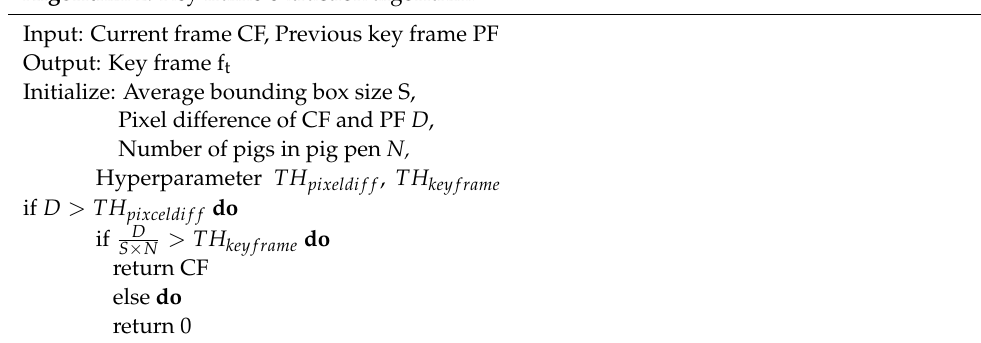
Algorithm 2. Key frame extraction